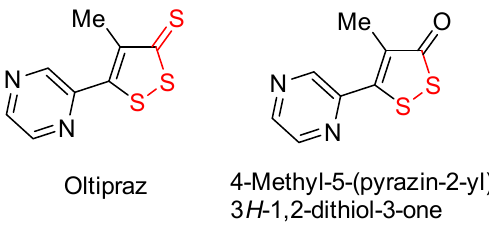
Figure 1. Oltipraz and 4-methyl-5-(pyrazin-2-yl)-3 H -1,2-dithiol-3-one.